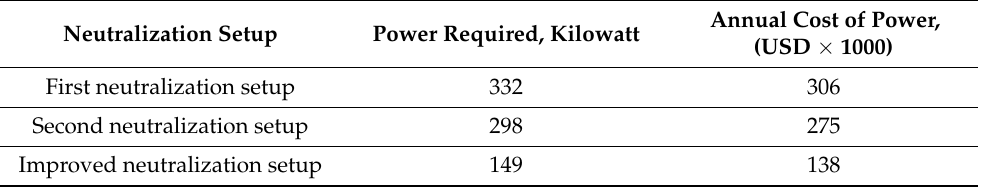
Table 4. Chemical usage summary for different neutralization setups.